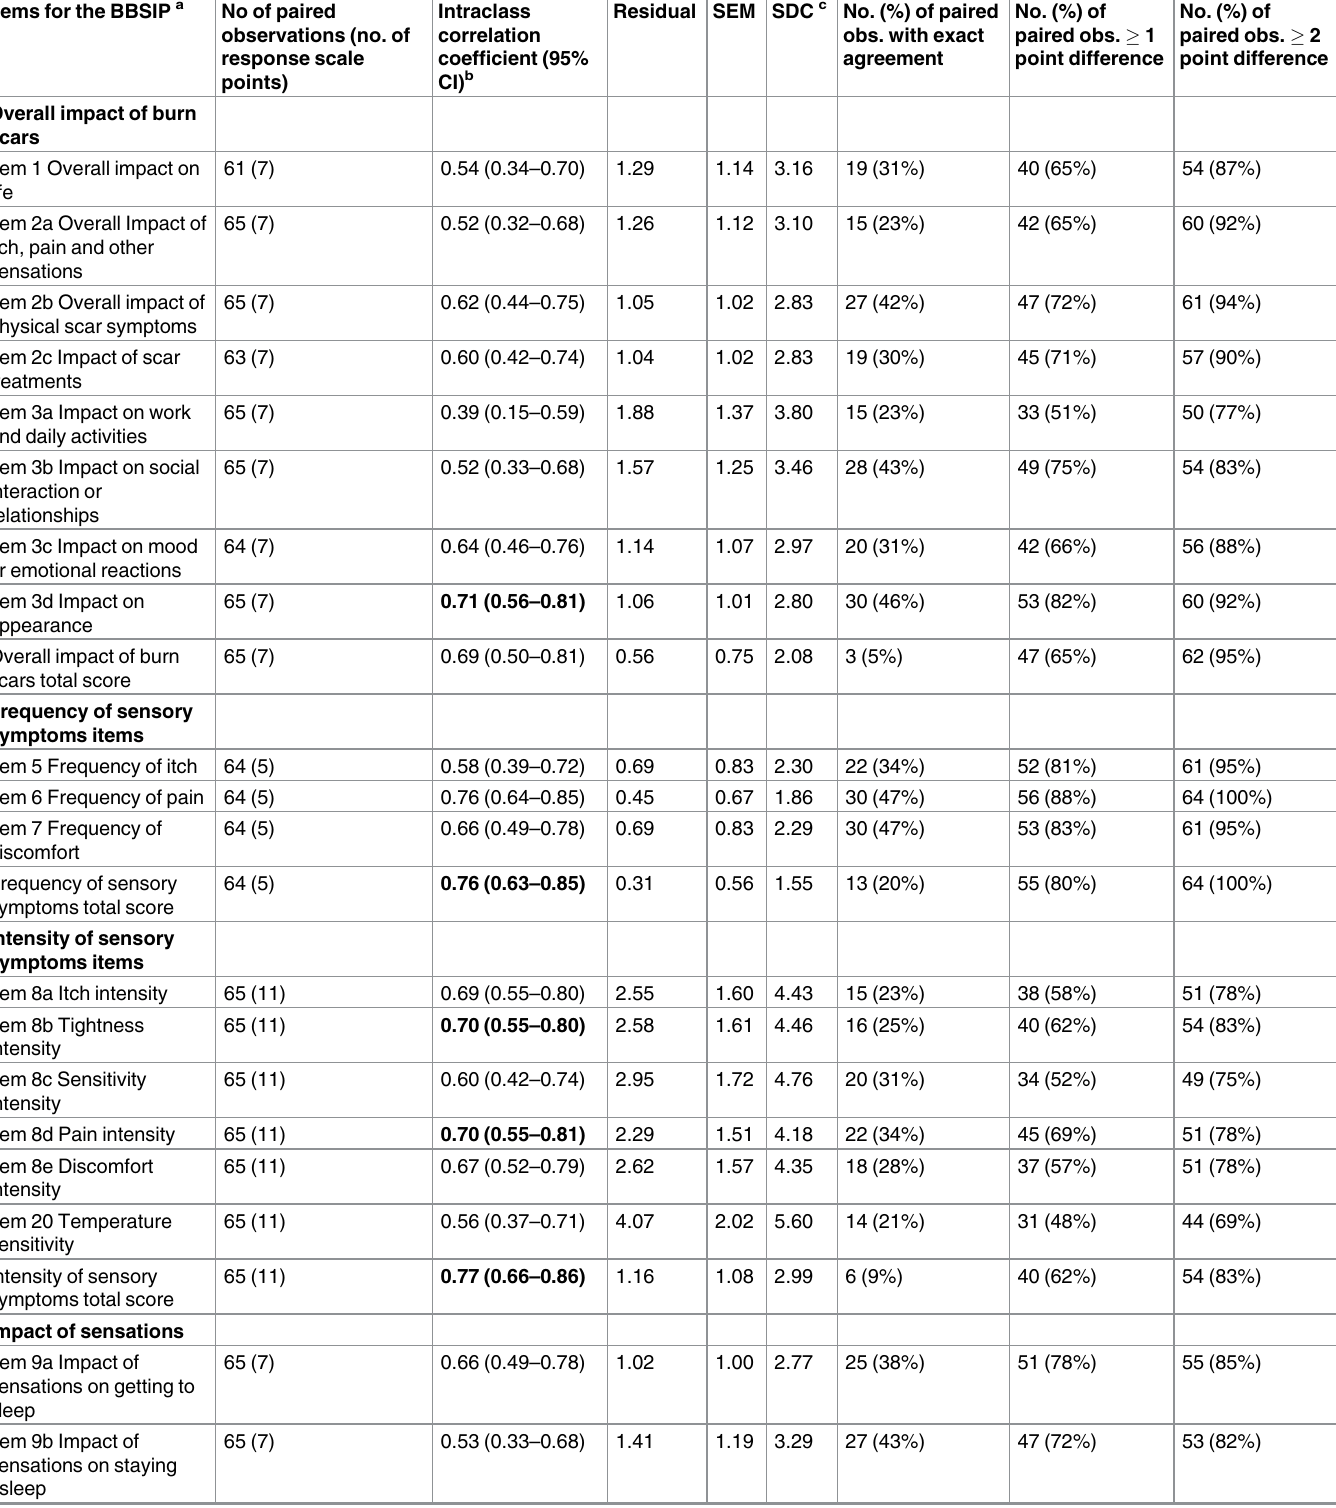
Table 4. Reproducibility of the BBSIP and POSAS individual items and BBSIP subscale scores using a one to two week retest period. Items for the BBSIP